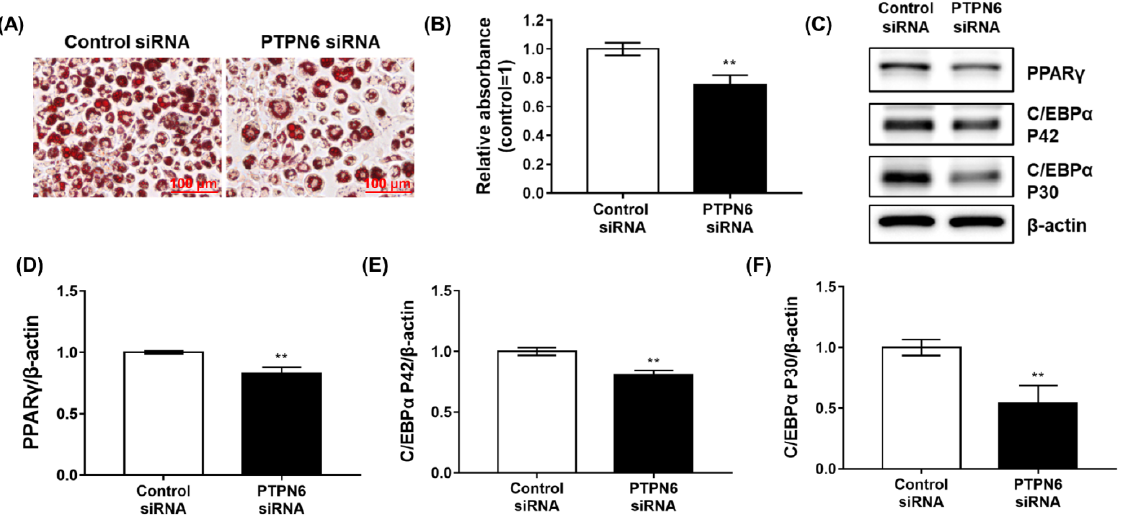
Figure 2. siRNA knockdown of PTPN6 suppresses adipogenesis of 3T3-L1 preadipocytes. After the knockdown of PTPN6 using siRNA for 48 h, 3T3-L1 preadipocytes were differentiated by DMI- induction for 6 days (DMI: dexamethasone, methylisobutylxanthine, and insulin). Lipid droplets of 3T3 ‐ L1 adipocytes were stained using the Oil red O working solution and visualized. Scale bar, 100 μ m. ( A ). Quantitative data on the lipid content were analyzed with extracted Oil red O using 100% isopropanol ( B ). For Western blot analysis, the cells were lysed after 48 h of differentiation. Western blot was performed using anti ‐ PPAR γ , C/EBP α , and β‐ actin antibodies ( C ). Quantification was performed for PPAR γ ( D ), C/EBP α P42 ( E ), and C/EBP α P30 ( F ), and each was normalized to control using CSAnalyzer 4. Data are shown as mean ± standard deviation ( n = 3). ** p < 0.01. Statistical significance was analyzed by a two ‐ tailed unpaired t ‐ test.